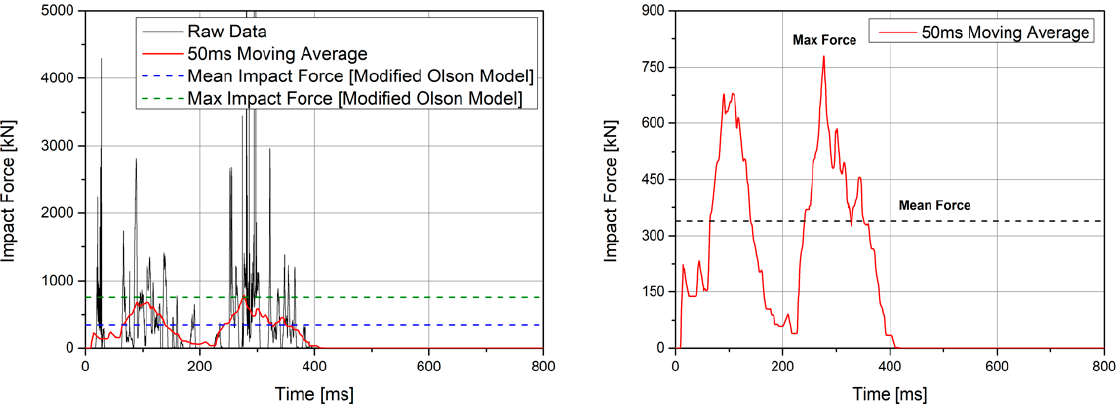
Figure 17. Impact forces occurred on the DCP during collision. Table 8. Comparison of theory and simulation.